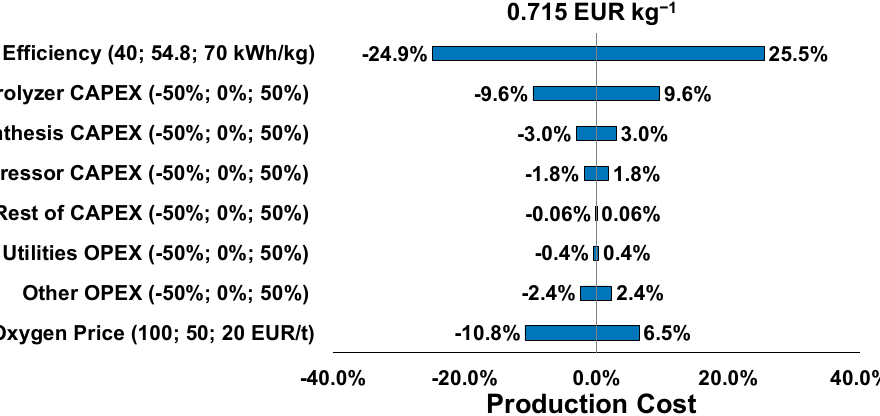
Figure 15. Sensitivity analysis of different cost components in the MeOH case.